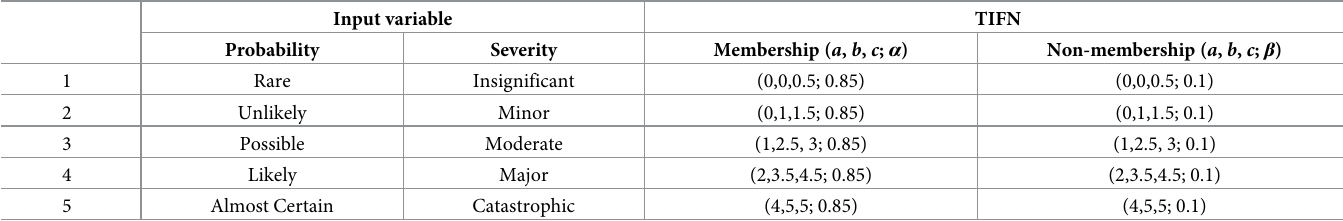
Table 2. Linguistic values and the parameters of membership and non-membership functions of TIFNs for two input variables: Severity and probability.